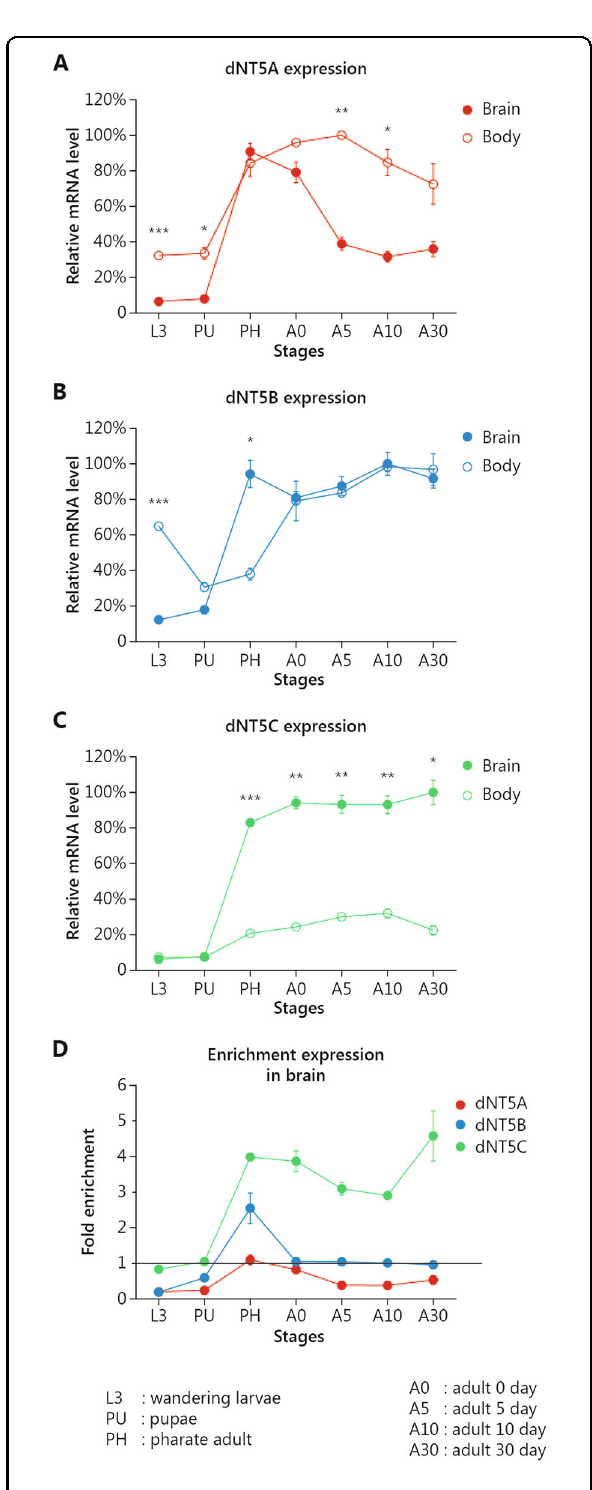
Fig. 1 dNT5 genes are expressed in the Drosophila brain, where dNT5C shows the highest enrichment compared to dNT5A and dNT5B . A – C mRNA levels of A dNT5A , B dNT5B , and C dNT5C in brain ( fi lled circles) and rest of the body (empty circles) at different developmental stages, quanti fi ed by qRT-PCR relative to the maximum value detected among the assessed stages (100%). D Enrichment of expression levels in the brain compared to the body for each individual dNT5 gene. Error bars represent standard error of the mean. Paired T -test was performed to obtain a p -value. (* p < 0.05, ** p < 0.01, *** p < 0.001). N = 3 biological replicates/stage, ten animals/